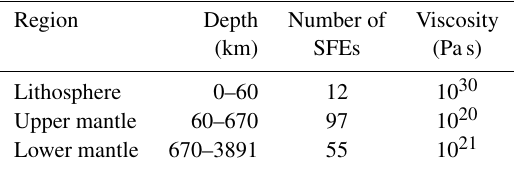
Table 1. Depth structure of VILMA model in this study with num- ber of spectral finite elements (SFEs) in the vertical direction per region and viscosity of the reference model. Region Depth Number of Viscosity (km) SFEs (Pas) Lithosphere 0–60 Upper mantle 60–670 Lower